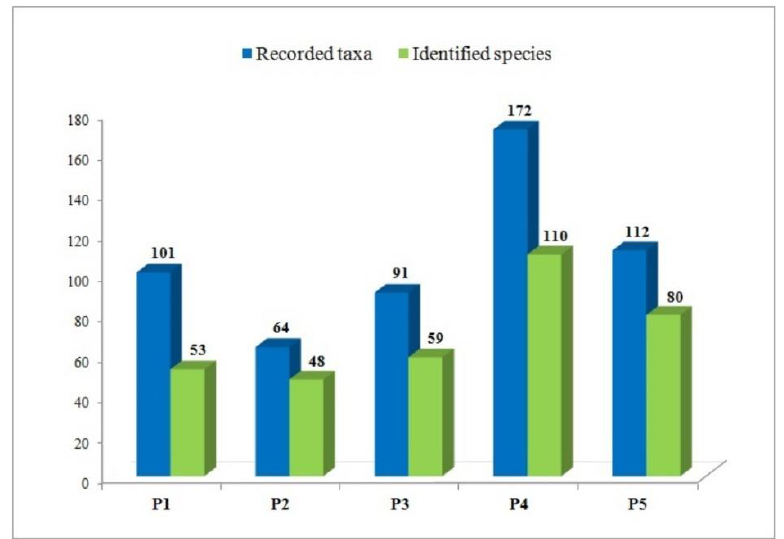
Figure 2. Map of Serbia, with locations of the study areas and representative forest plots.